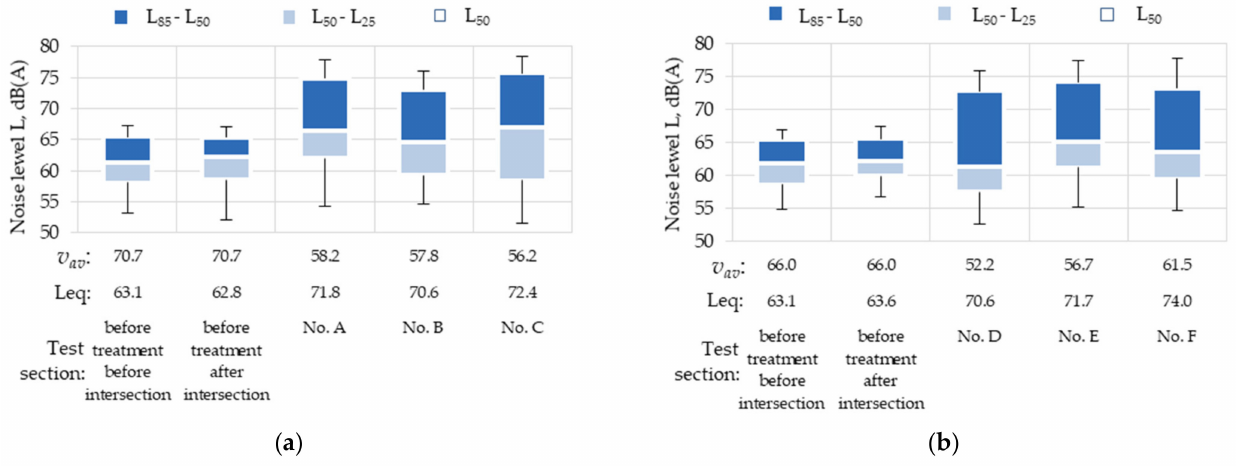
Figure 10. Estimated noise ranges on the test sections, dB(A): ( a ) Westbound carriageway—ca. 600 m long straight approach section of the road; ( b ) Eastbound carriageway—ca. 130 m long straight approach section of the